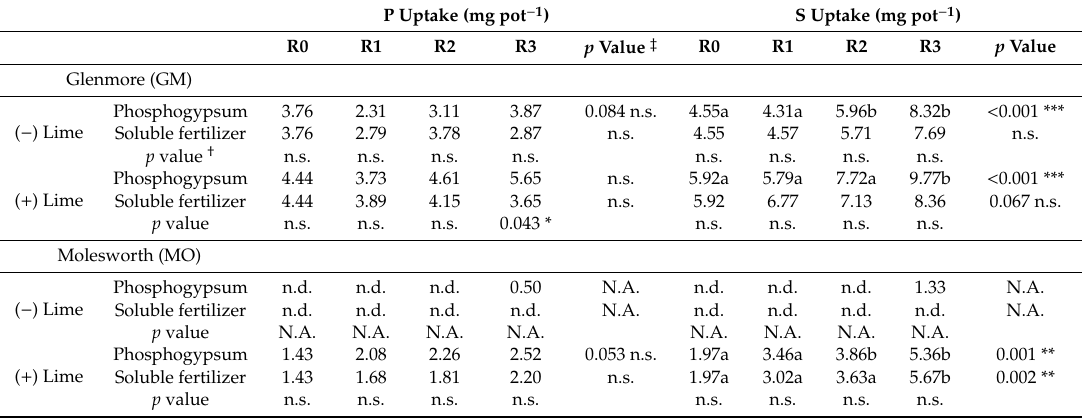
Figure 2. Comparison between the e ff ects of phosphogypsum (PG) and soluble fertilizer (PS) on total dry matter yield (g pot − 1 , n = 4) of lucerne ( Medicago sativa ) after six month growth period under two different soils: Molesworth ( a ) and Glenmore ( b ) treated (+) or not ( − ) with lime. Error bars indicate standard errors (± SEM, n = 4). Means of TDM for PG and PS per rate (R0 to R3) were separated using a two-sample t -test at 5%, means indicated by the same lower-case letter per rate are not significantly different. Asterisks above bars indicate the application rate where TDM was significantly higher compared to the corresponding control under PG and PS separately, according to the Dunnett test at 5%. ** indicates a one-way ANOVA significance level (1%). Table 2. The e ff ects of phosphogypsum (PG), soluble fertilizer (PS) and lime on lucerne ( Medicago sativa ) shoot P and S uptakes from Glenmore and Molesworth soils after a six-month plant growth period. Within rows, means followed by the same lower-case letter are not significantly di ff erent (Dunnett test at 5%, R0 = control). Within columns, means were compared using a two-sample t -test at